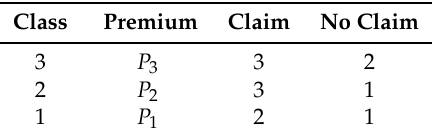
Table 1. Transition rules for the 3 class Bonus-Malus